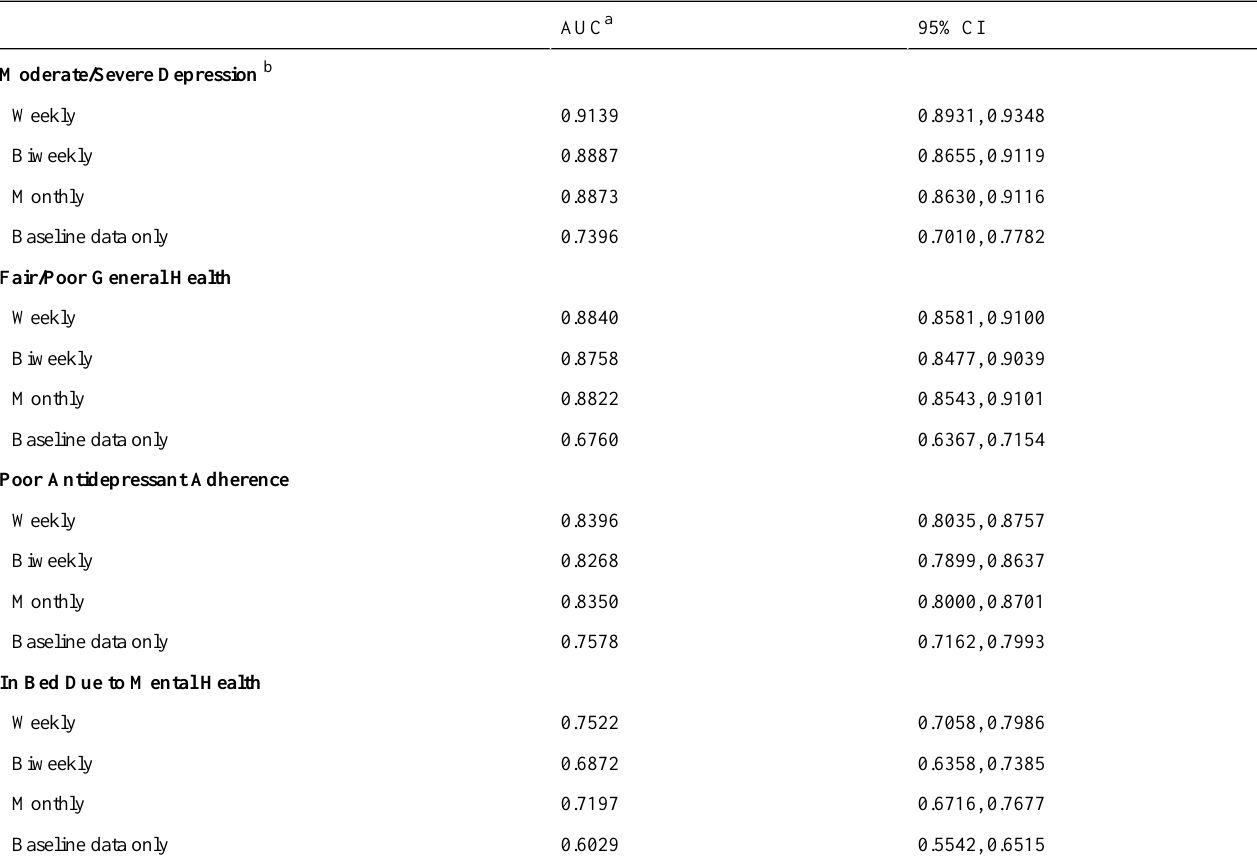
Table 3. Area under the Receiver Operator Characteristic (ROC) curve for logistic models predicting each health indicator assuming different assessment